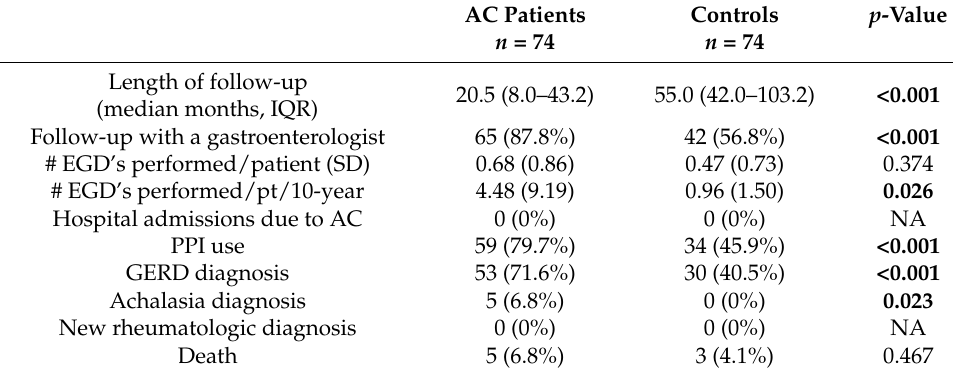
Table 2. Follow-up of absent contractility patients versus controls. AC Patients